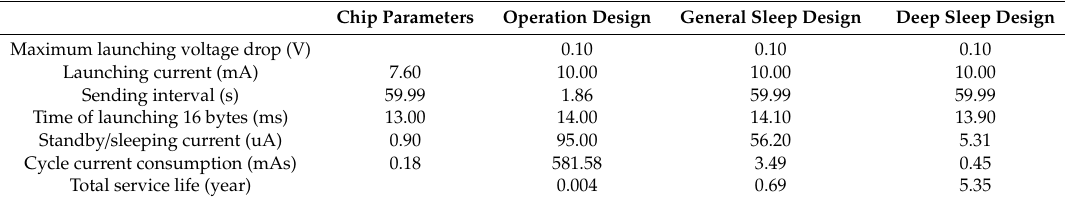
Table 2. Summary of test conditions and comparison of the battery current consumption.